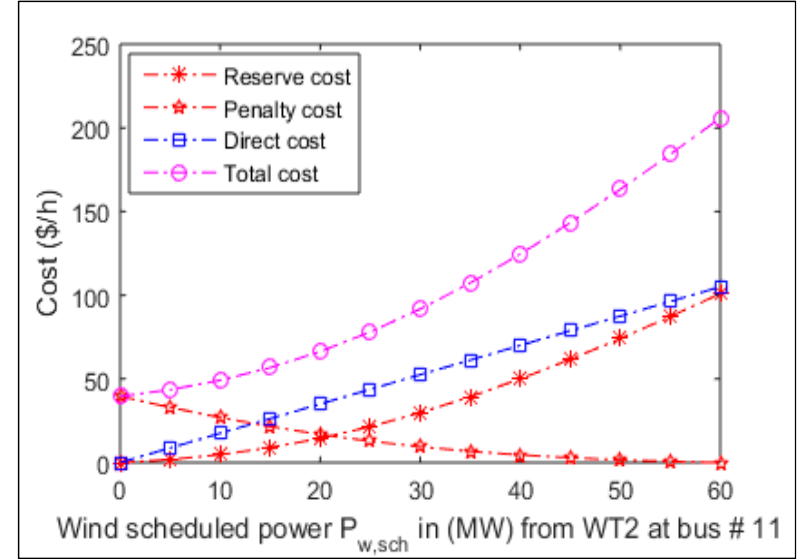
Figure 11. Cost vs. wind schedule power (MW) (bus#11).